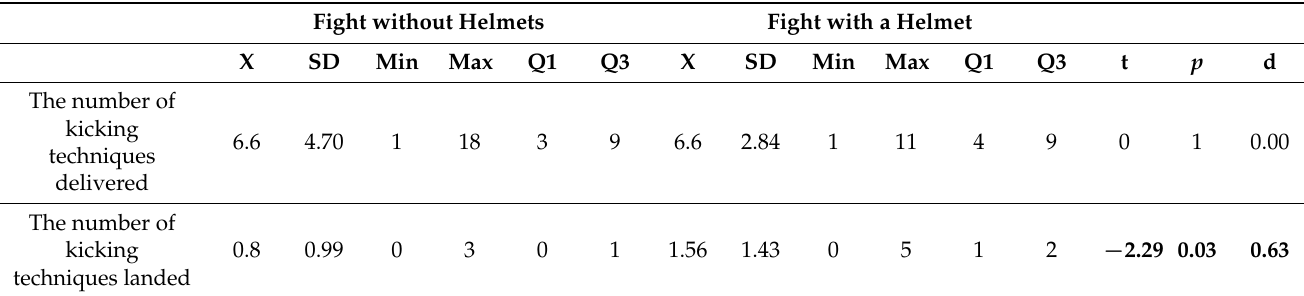
Table 4. Descriptive and comparative statistics of fights with and without a helmet in relation to kicking